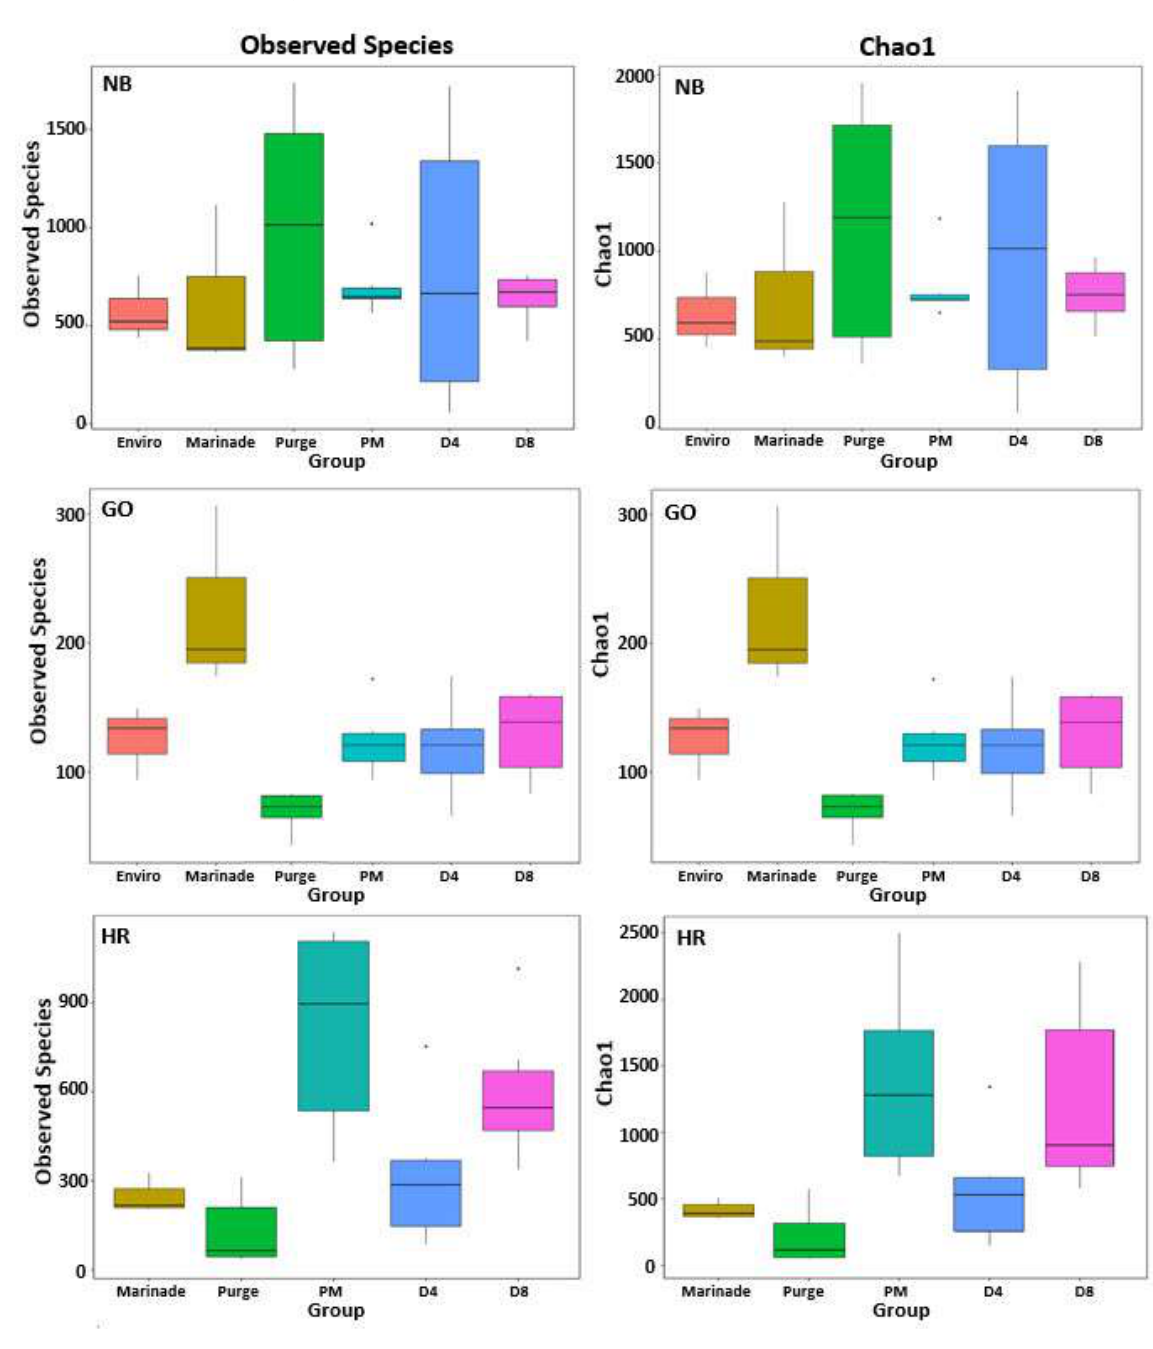
Figure 5. Box plot of differences between groups of Observed Species and Chao1 from different beef processors (Nebraska Beef, NB; Greater Omaha, GO; High River, HR). Wilcox rank sum test and Tukey test were used to analyze the differences and significance ( p < 0.05) in species diversity